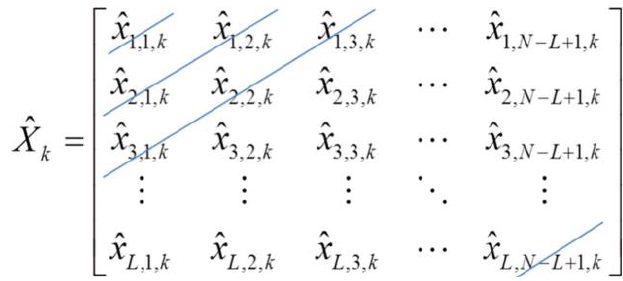
Figure 1. The diagonal averaging operation.